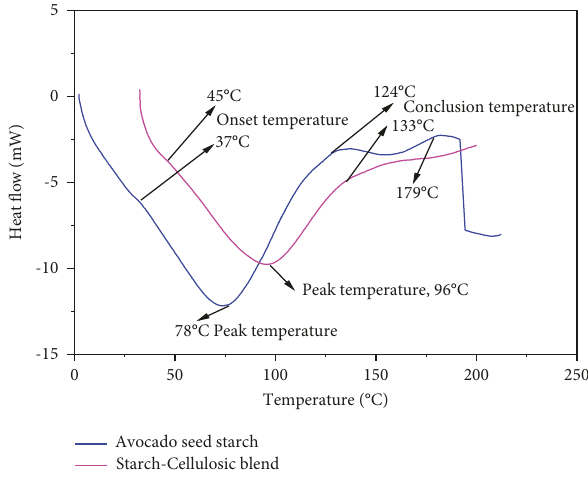
Figure 4: DSC thermograms of avocado starch and starch-cellulosic blend. Table 3: Thermal properties for the avocado starch and the starch-cellulosic